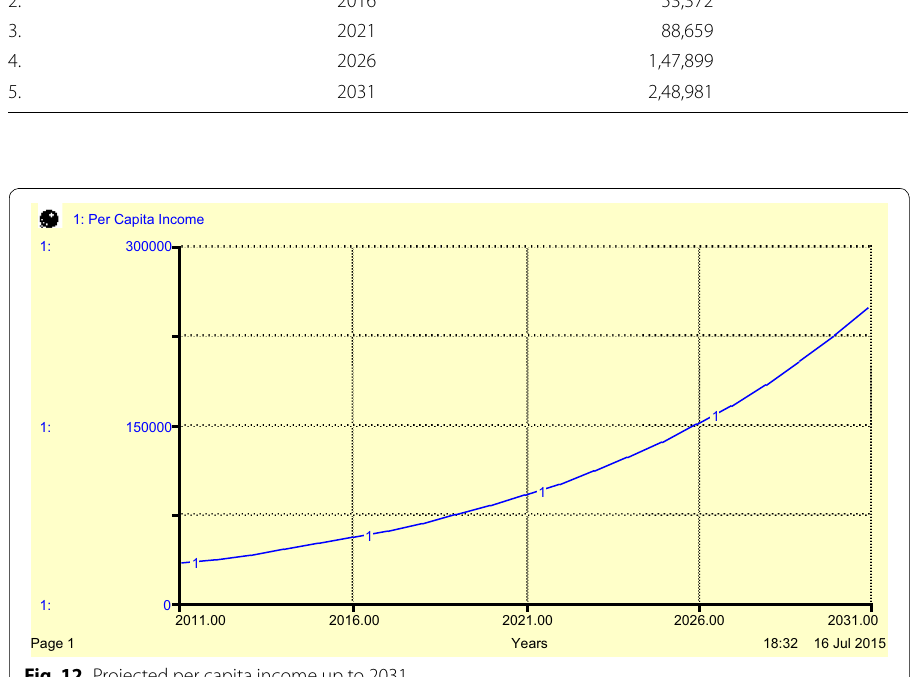
Fig. 12 Projected per capita income up to 2031